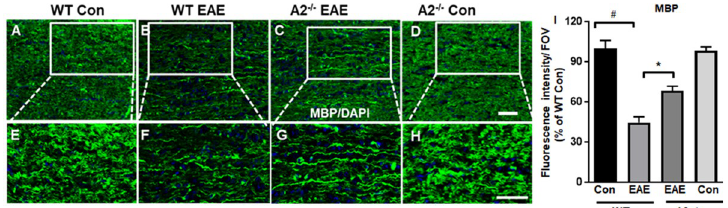
Fig 5. A2 deletion protected against EAE-induced demyelination. A-D) Representative images showing MBP staining. E-H) Higher magnification images from boxed areas showing the loss of myelin in WT EAE optic nerves while A2 deletion reduced the EAE-induced-demyelination. I) Quantification of immunofluorescence intensity of MBP. Number of animals used: 8(WT Control);12 (WT EAE); 9 (A2 -/- EAE); 7 (A2 -/- Control). Representative images are presented. Data are presented as mean ± SEM. #p < 0.01 WT EAE vs WT Con and � p < 0.05 A2 -/- EAE vs WT EAE. Scale bar 50 μ